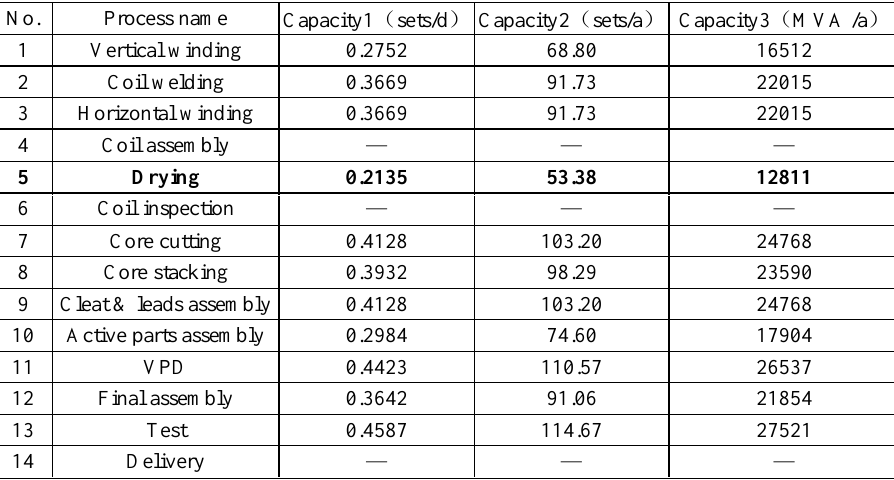
Table 4. Capacity of each